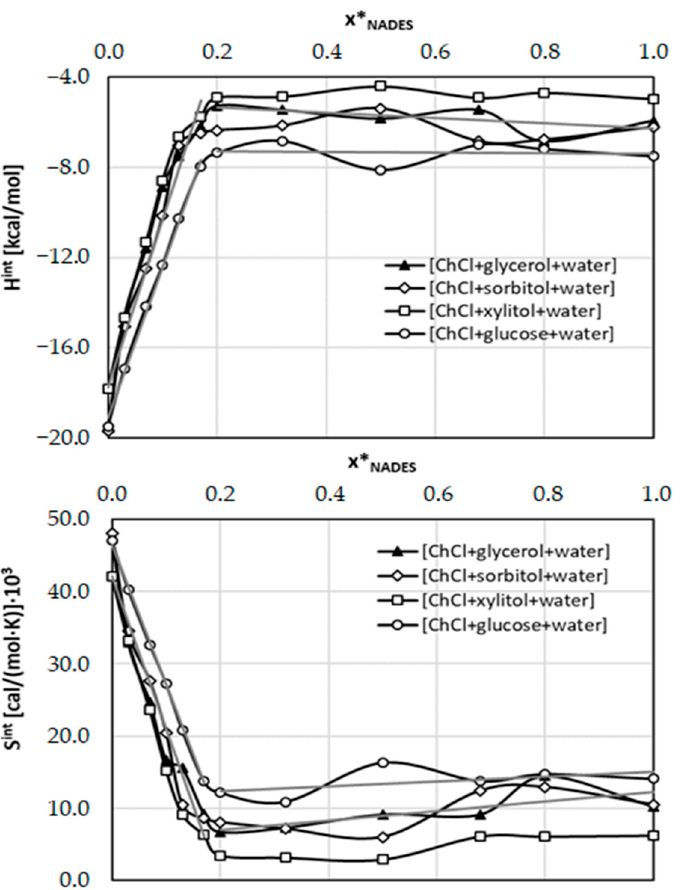
Figure 12. The optimal values of adjustable intermolecular parameters H int and S int introduced in the COSMO-RS-DARE approach for caffeine solubility computations in ternary systems comprising water.